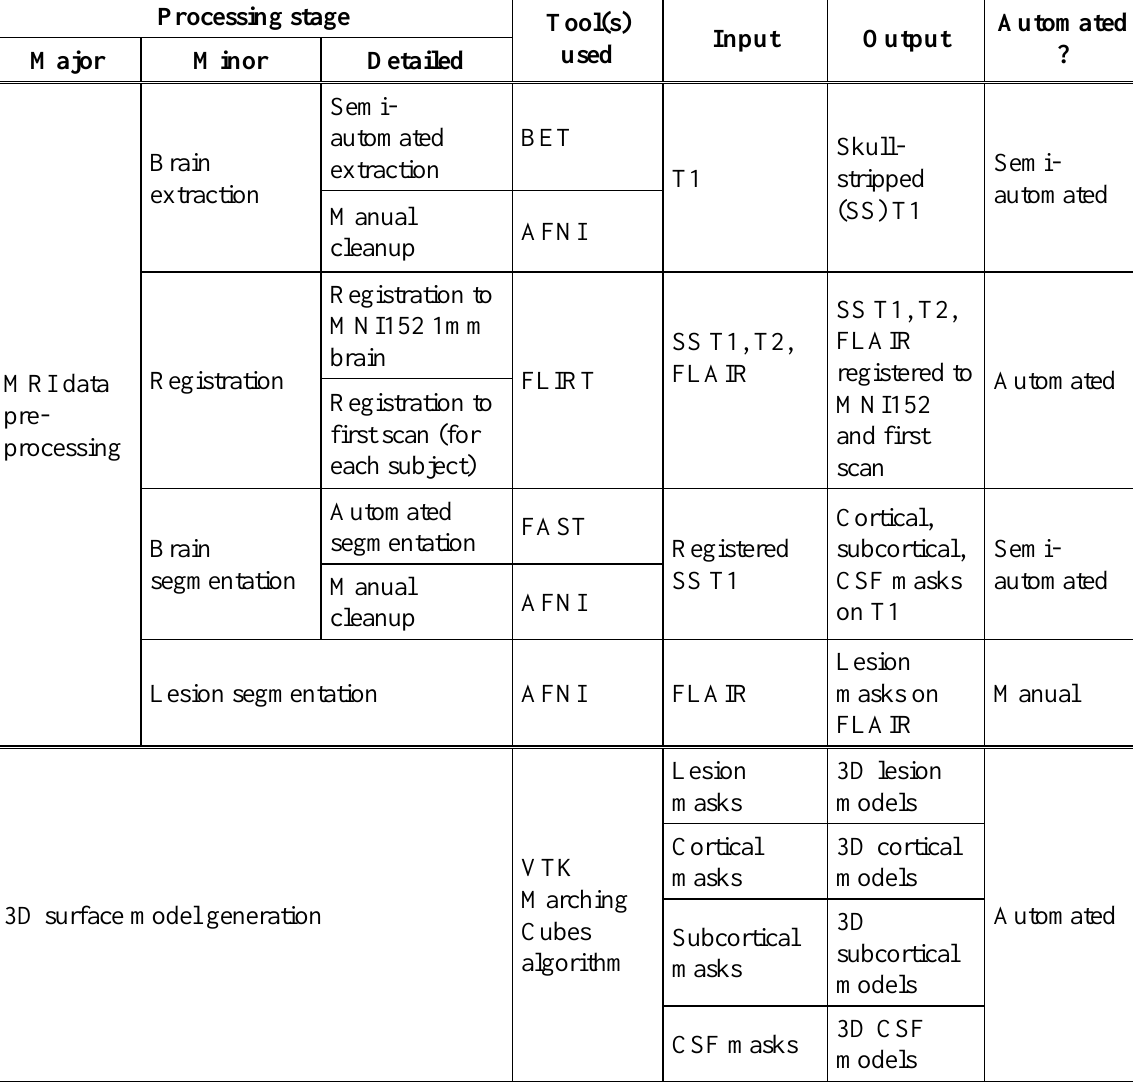
Table 1: Detailed processing stages of MRI data pre-processing and 3D surface model generation. For each stage, the tools used, input data, and output data are